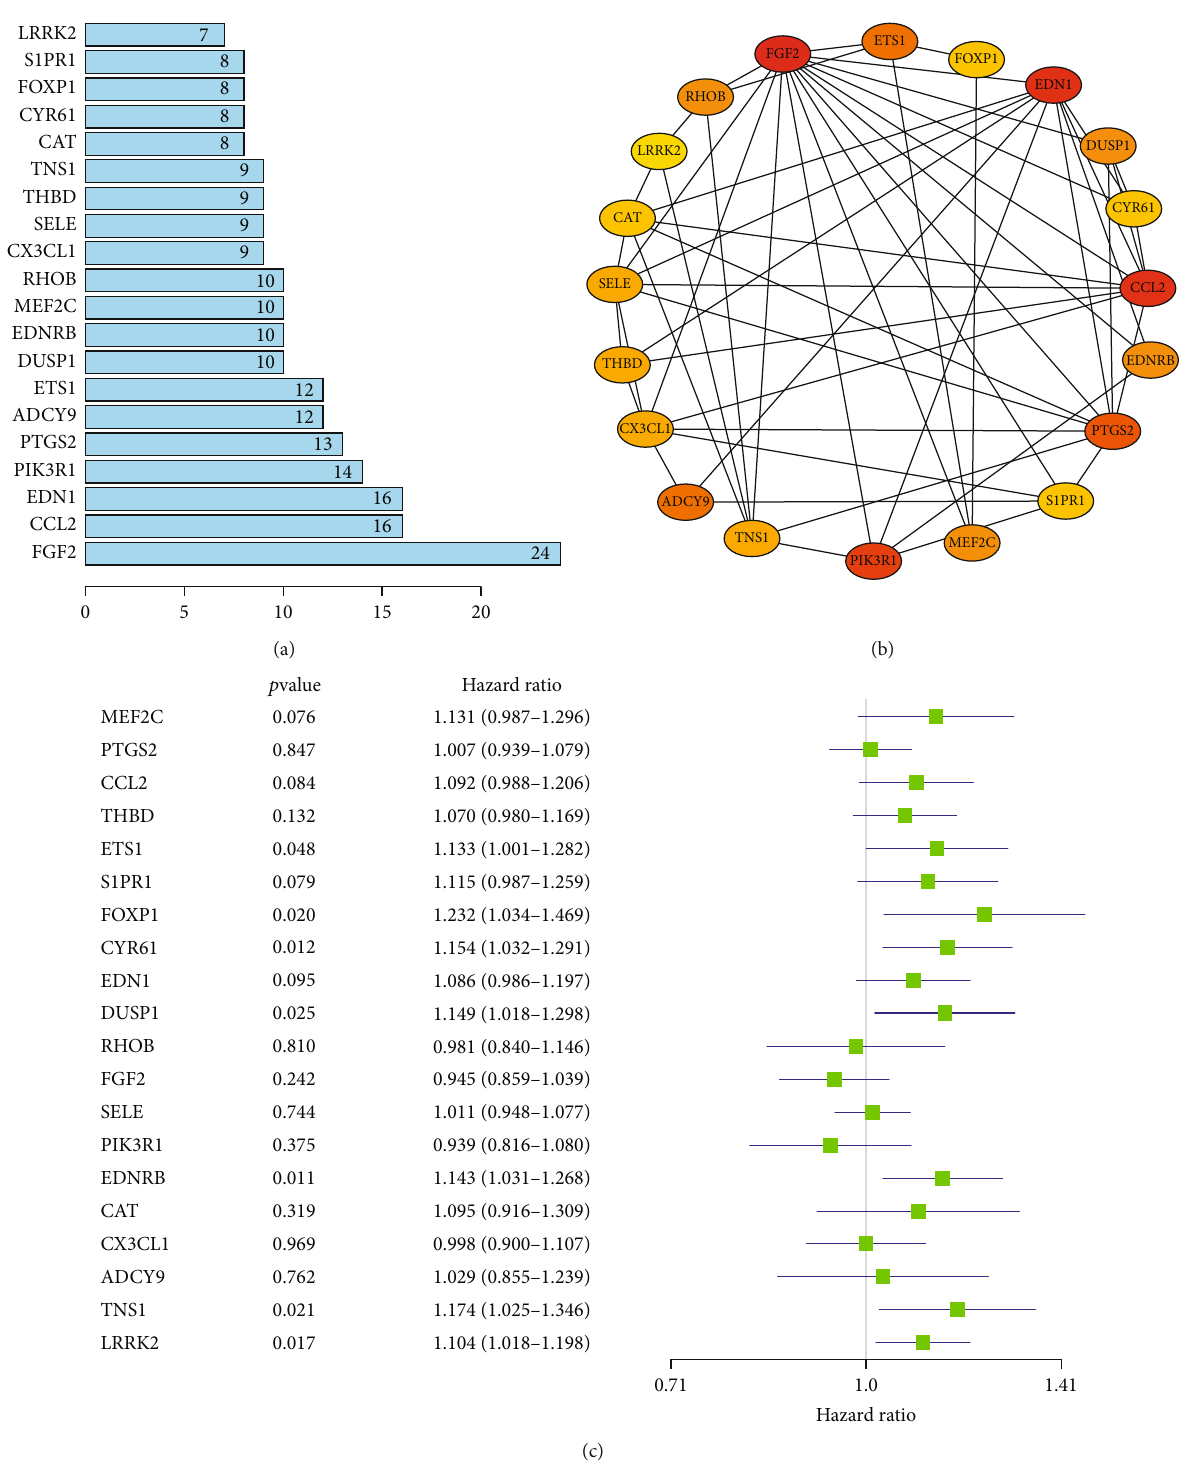
Figure 8: PPI network and hub gene analysis. (a) Histogram of top 20 key genes. The y -axis represents the name of genes, the x -axis represents the number of adjacent genes, and height is the number of gene connections. (b) PPI network of top 20 key genes. (c) Cox univariate regression analysis of top 20 hub genes. P < 0 : 05 indicated statistically signi fi cant di ff